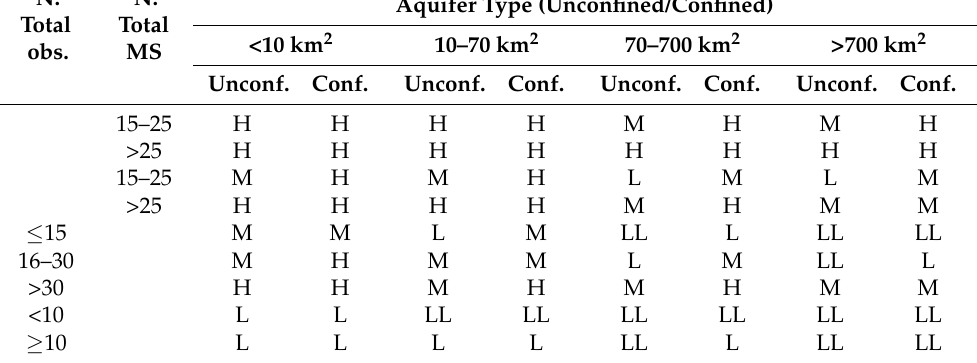
Table 1. Confidence levels. The confidence level attributed to a NBL takes into account the charac- teristics of the dataset (case A, B, C, D), of the total number of observations and monitoring sites (MSs), also with reference to the extension of the GWB and the aquifer type (unconfined/confined). Confidence levels: H: High; M: Medium; L: Low; and LL: Very